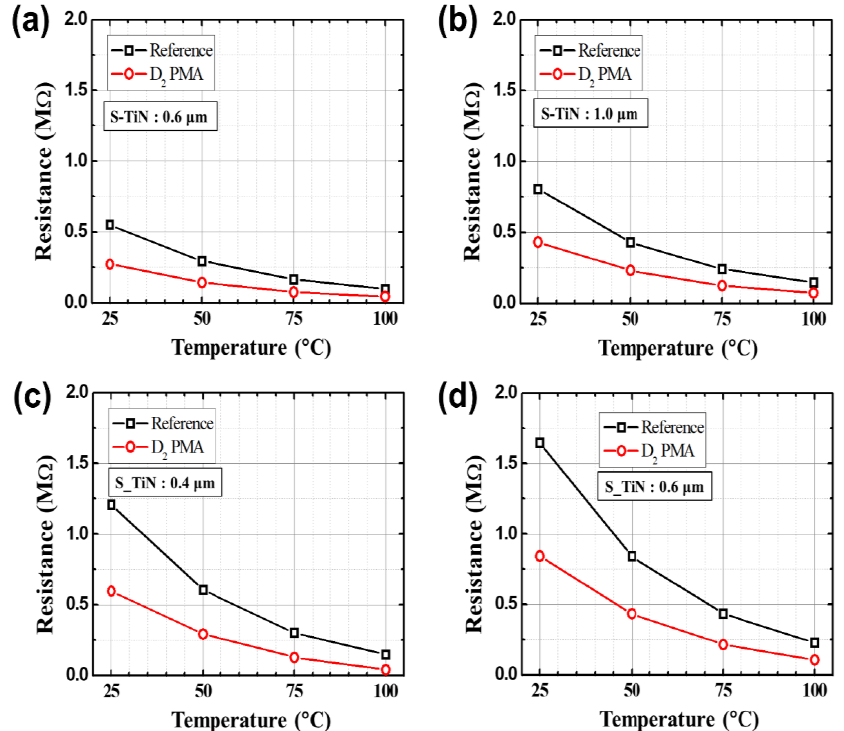
Figure 10. The resistance variations as a function of temperature for the four types of a-Si microbo- lometers before and after applying the PMA process: ( a ) P35-S06, ( b ) P35-S10, ( c ) P12-S04, and ( d ) P12-S06. Here, the S-TiN stands for the pattern spacing of TiN layer.